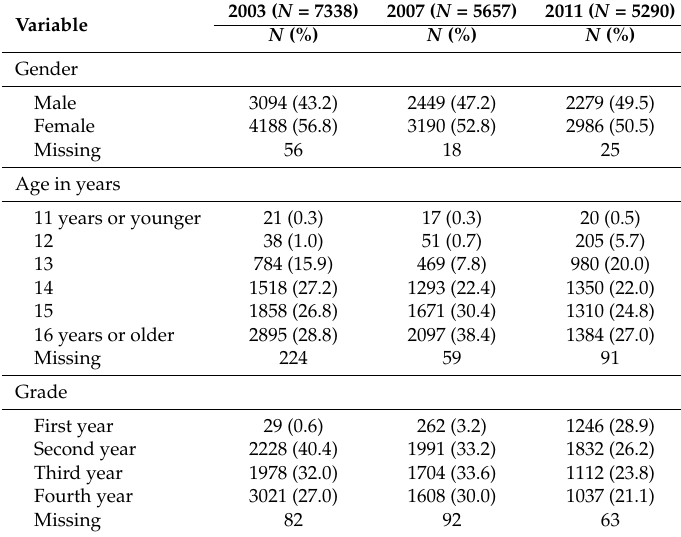
Table 1. Characteristics of participating students for 2003, 2007 and 2011 surveys ( N = 18,285).